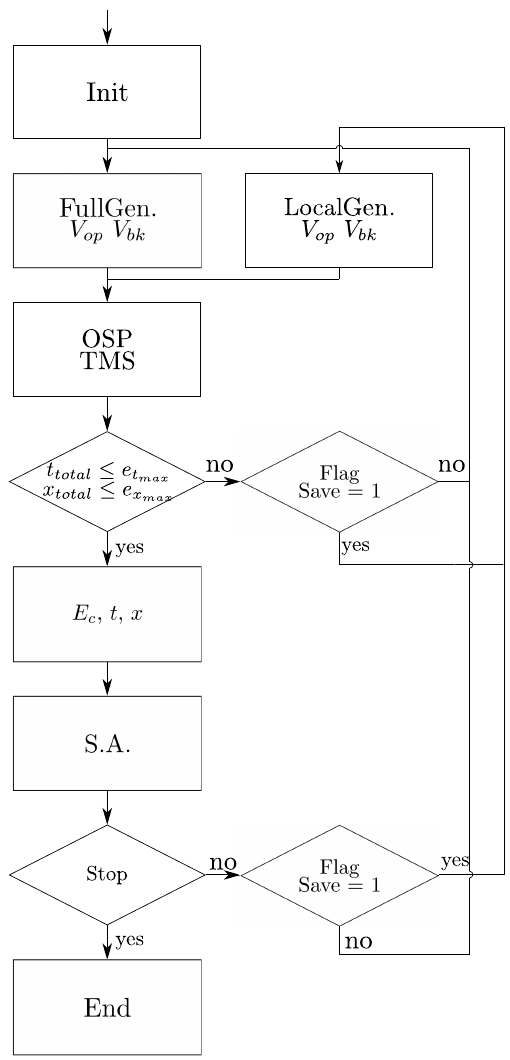
Figure 8. Optimization Algorithm Flowchart.